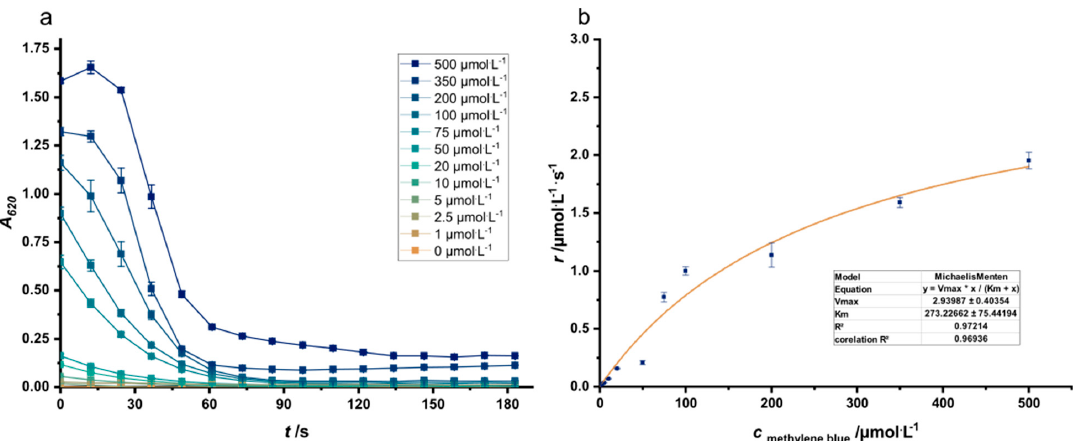
Figure 2. Reduction kinetics of methylene blue for Strain JG991 ( a ). Assays have been conducted in PBS minimal medium with an OD 600 = 6. The highest reduction rates have been fitted to a Michaelis-Menten model ( b ).